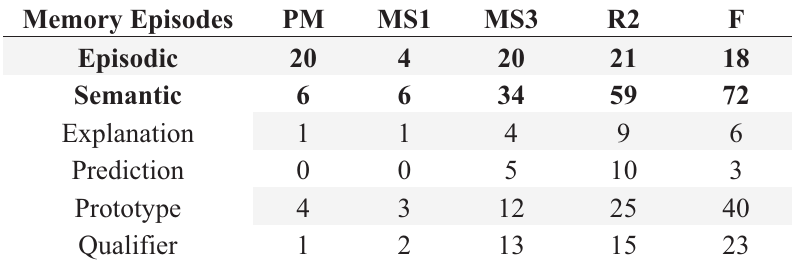
Table 3. Classification of responses to the trigger question, “Can you remember anyone with this disease?” Memory Episodes